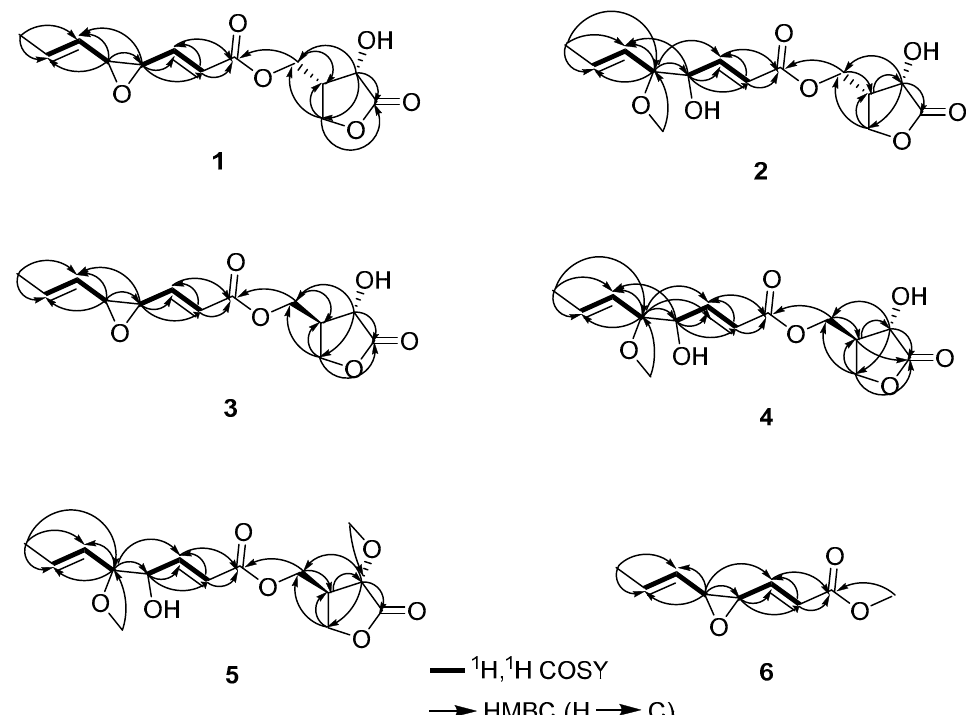
Figure 3. Key COSY (bold) and HMBC (arrows) correlations of compounds 1 – 6.